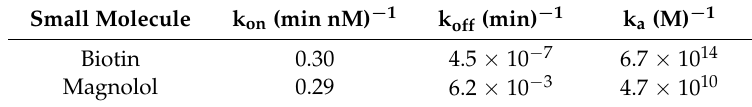
Table 1. Kinetic constants of biotin and magnolol binding to immobilized streptavidin.